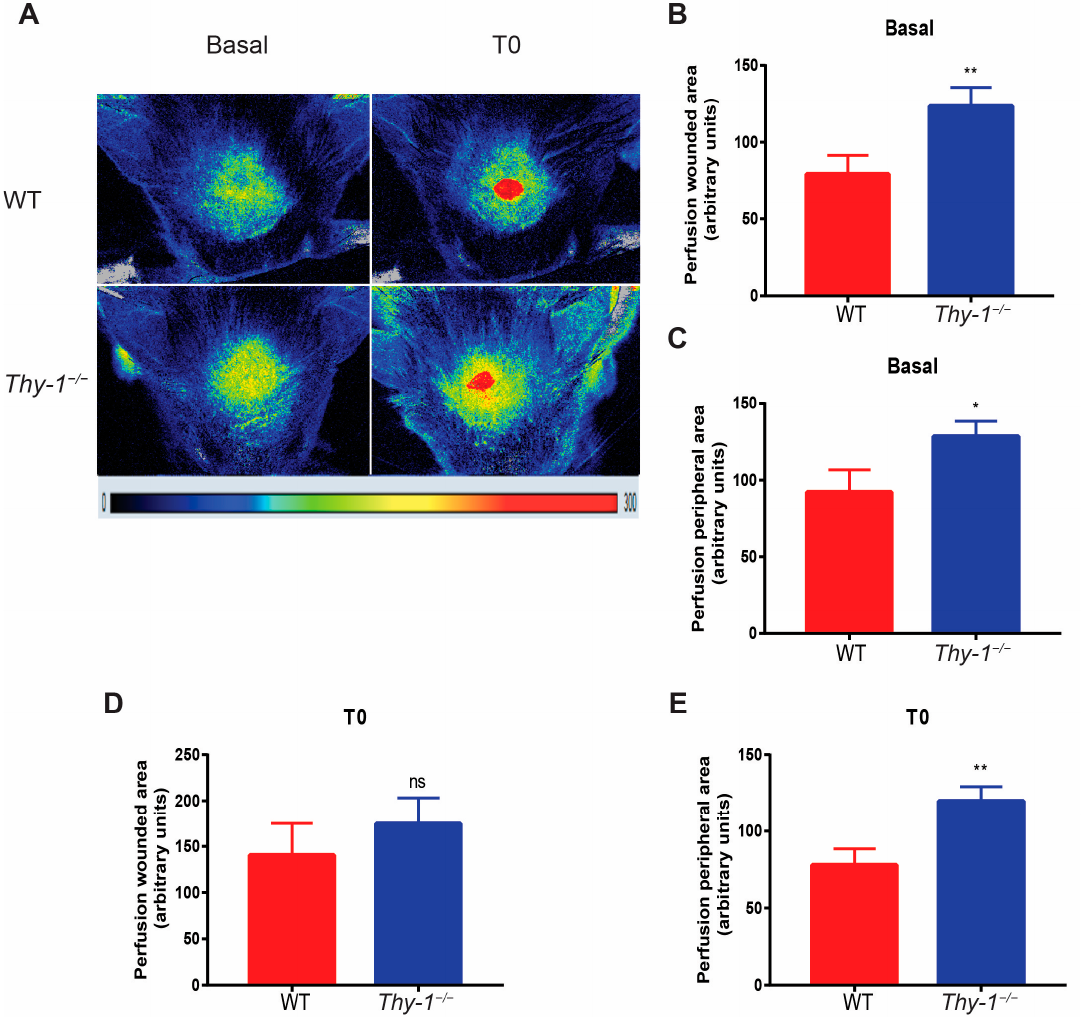
Figure 4. Blood perfusion in the wounded area in WT and Thy-1 − / − mice. ( A ) Representative images of blood perfusion in the wounded area in WT ( n = 10, upper) or Thy-1 − / − mice ( n = 8, bottom). Representative images of basal blood perfusion before skin injury, where T0 represents blood perfusion immediately after skin injury. Quantification of basal blood perfusion in the wounded area ( B ) and peripheral area ( C ) is shown. For T0, the quantification of blood perfusion in the wounded area ( D ) and peripheral area ( E ) is presented. Values are presented as mean ± SEM. ns, non-significant; * p -value < 0.05, ** p -value < 0.01 versus WT mice.